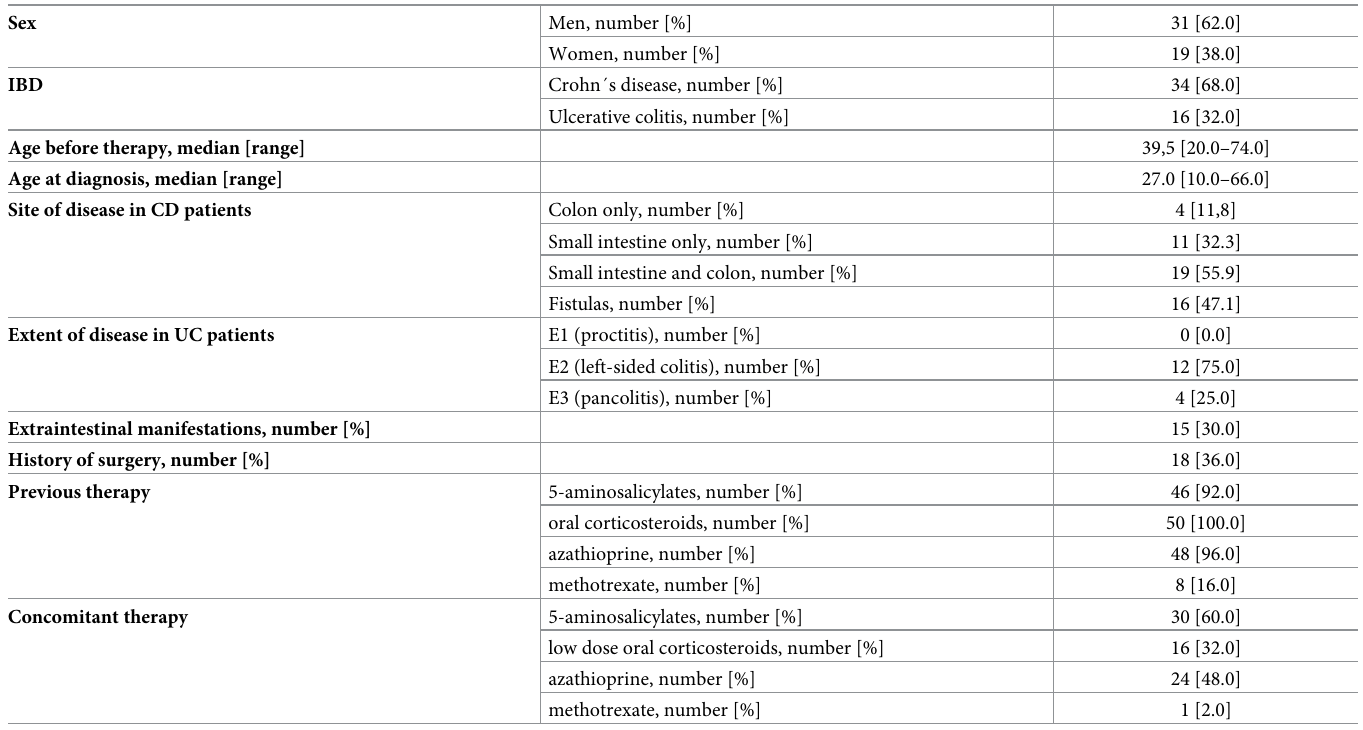
Table 1. Baseline patient demographics and clinical